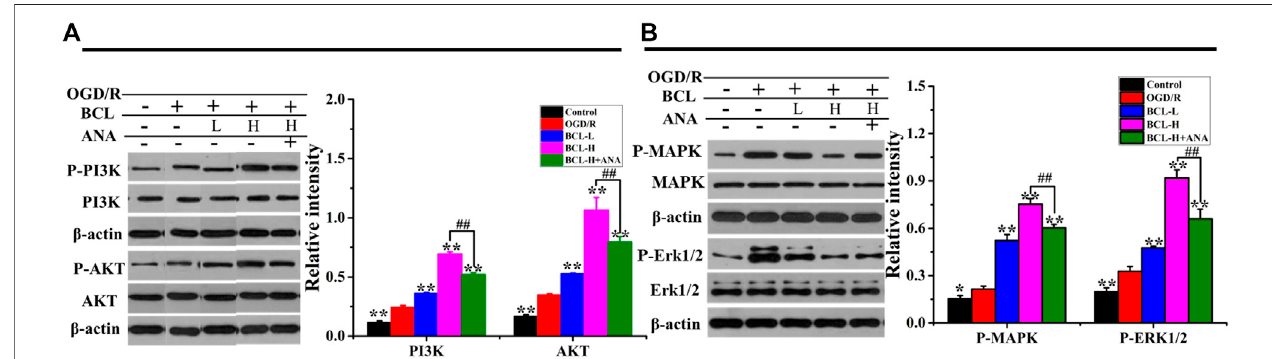
FIGURE 10 | Effects of BCL (34.38 μ g/mland 8.59 μ g/ml) and ANA12 on the expression of PI3K, Akt, MAPK, and ERK in NA systems after OGD/R. (A) The effect of BCL on the expression of PI3K and Akt in the NA system after OGD/R. (B) The effect of BCL on the expression of MAPK and ERK in NA systems after OGD/R. Quanti fi ed results were normalized to β -actin expression. ** p < 0.01, vs. OGD/R group; ## p < 0.01, BCL-H group vs. BCL-H + ANA group.